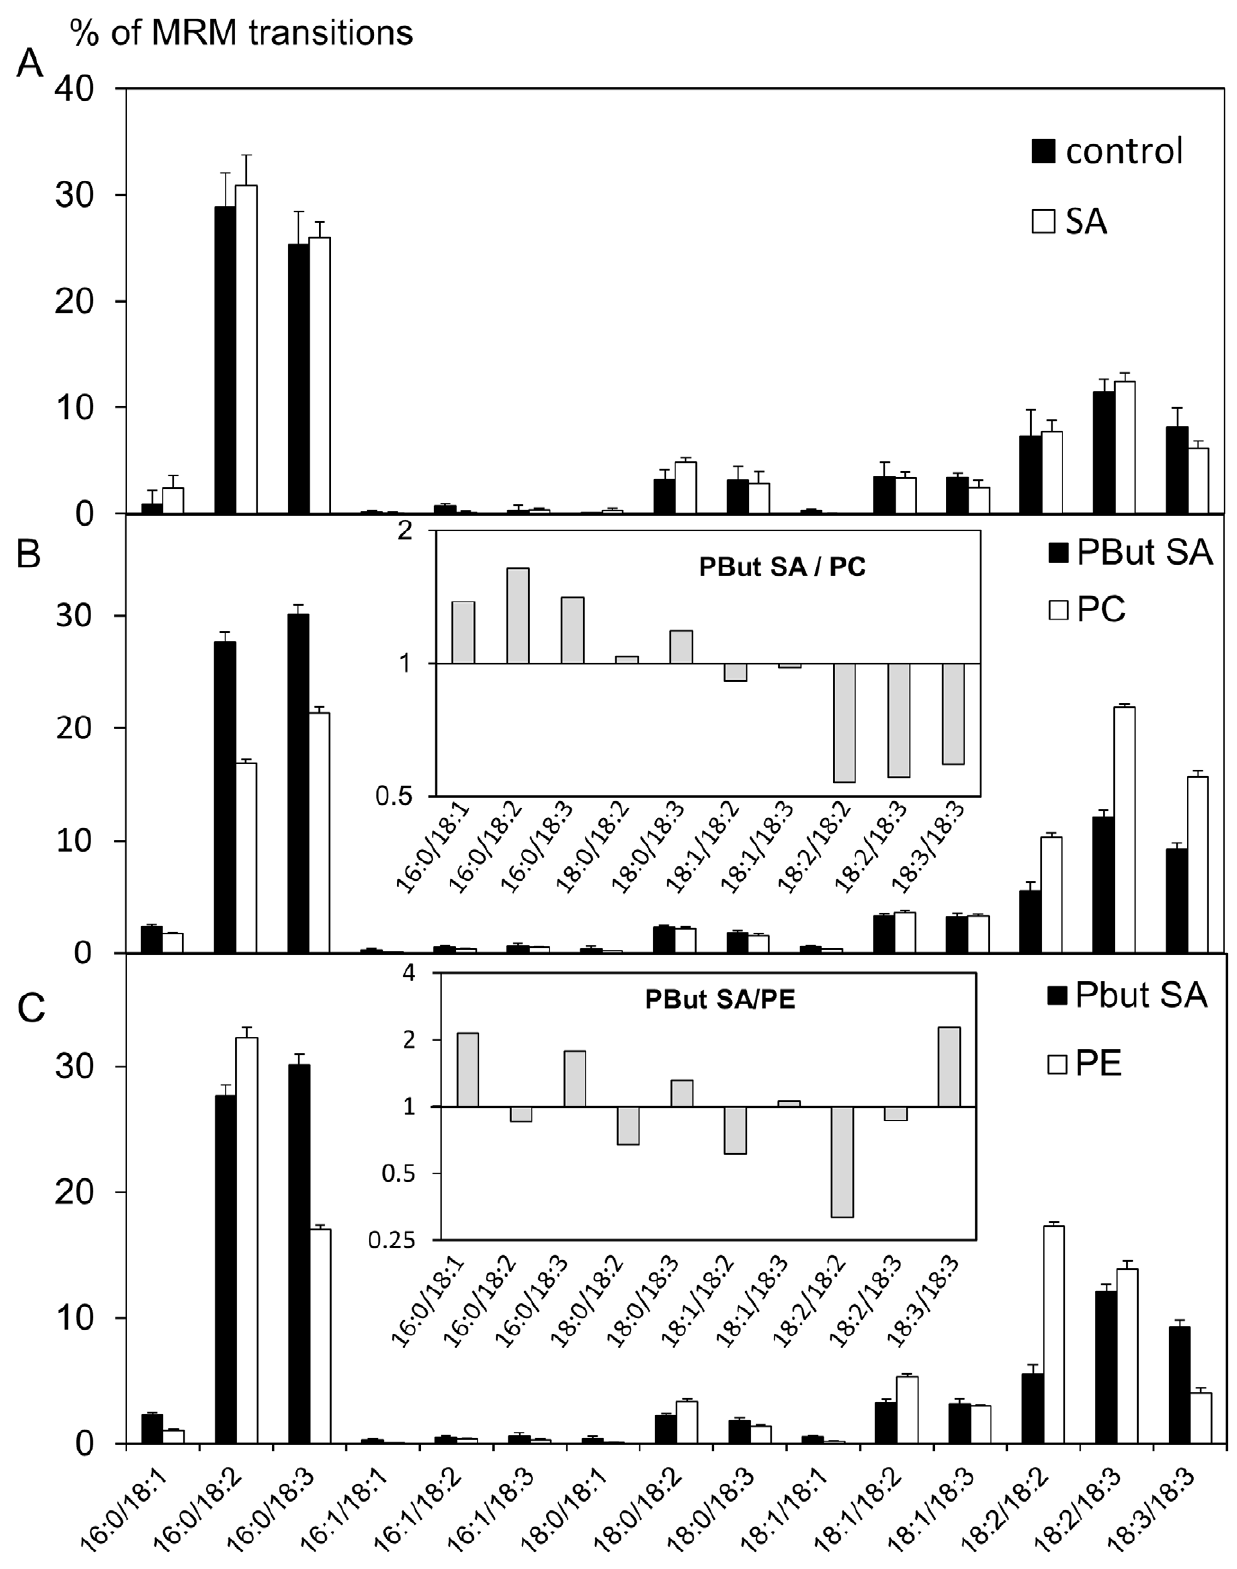
Figure 4. PBut profiles analyzed before and after SA addition. Cell medium was supplemented with 0.1% (v/v) n -butanol. After 45 minutes, 750 m M SA was added, and lipids were extracted 100 min later. (A) Black bars, PBut in untreated cells; white bars, PBut in SA treated cells; striped bars, PC; grey bars, PE. (B) PBut in the presence of SA compared to PC. Black bars, PBut in presence of SA; white bars, PC. Insert: for molecular species representing more than 1% of the species of PBut and PC, we calculated the ratio of the value obtained in PBut to the value obtained in PC. Results